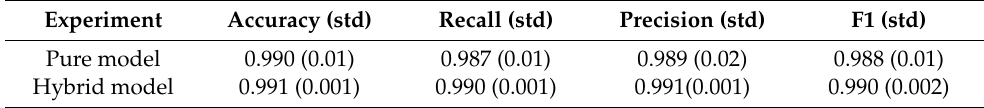
Table 3. Results of the classification